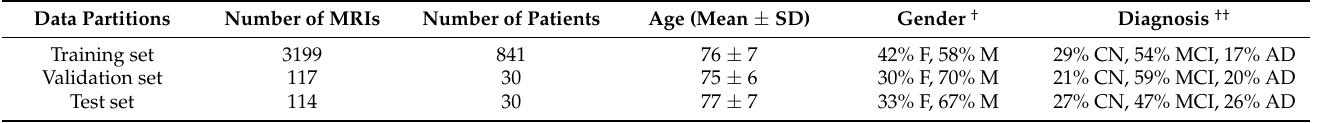
Table 1. Study participants tabulated by the training, validation, and test